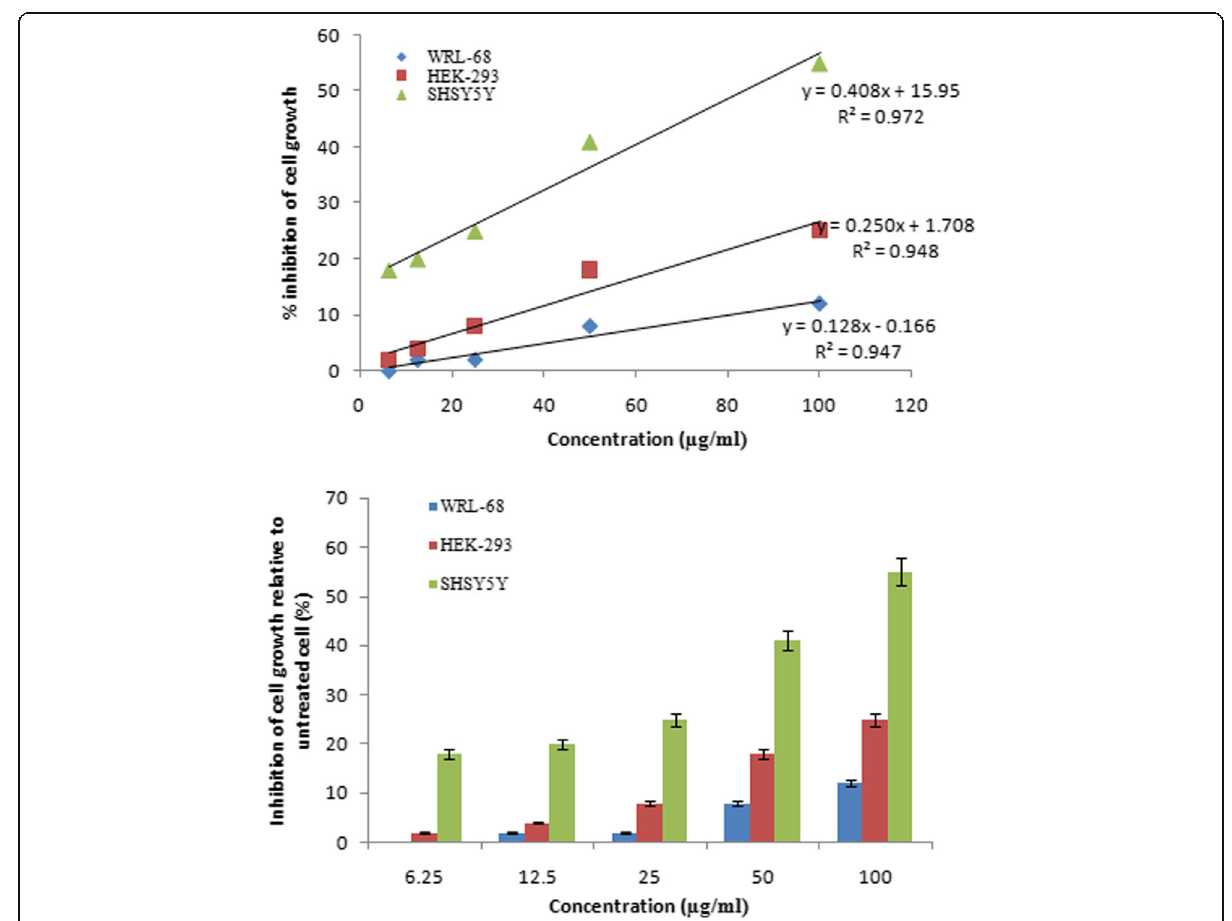
Fig. 5 Cytotoxicity effects of AR rhizome extract against the Neuroblastema cell (SHSY5Y), Human Embryonic kidney cell (HEK- 293) and Liver cell line (WRL-68). Data represent the mean of three